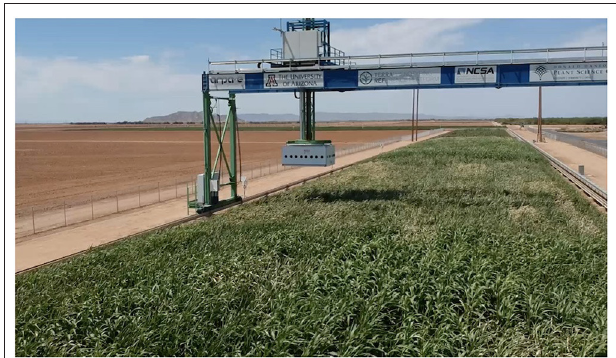
FIGURE 2 | The TERRA-REF Field and Gantry-based Field Scanner in Maricopa, Arizona, with sorghum being grown in the